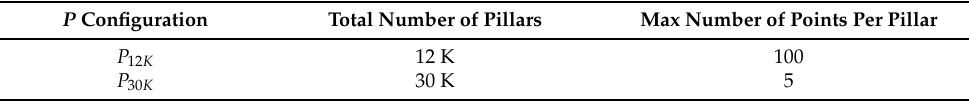
Table 5. Total number of Pillars used in fine-tuning.